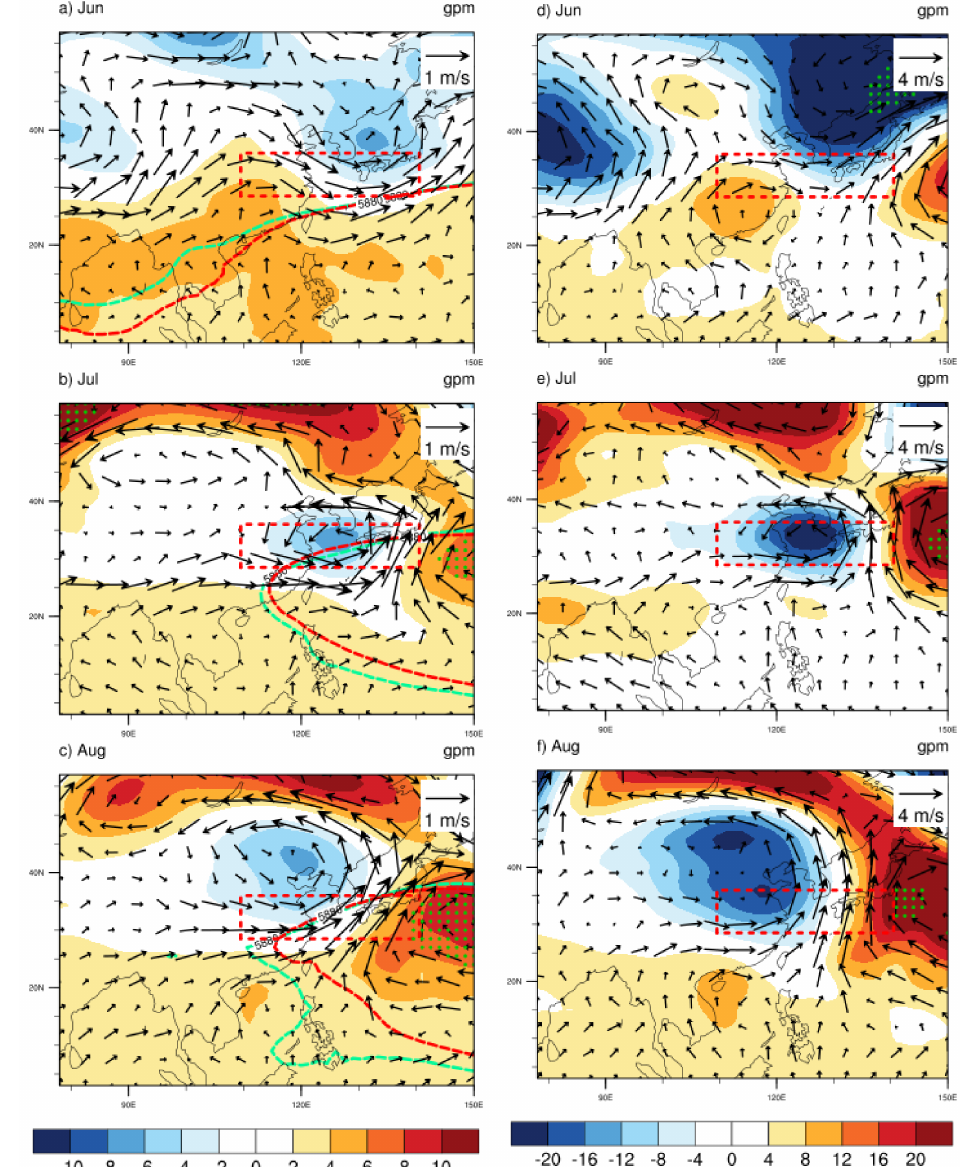
Figure 5. Regression maps ( a – c ) of 500 hPa geopotential height (shading) and winds (vectors) onto PC1. Green line represents the regression 5880 line and red line represents the climatological mean 5880 line. The difference maps ( d – f ) of the same elements between the five most positive years and the five most negative years in PC1. Stippled areas indicate geopotential height anomalies and differences that exceed the 90% confidence